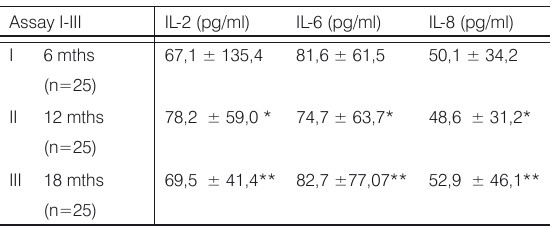
Table 2. Serum IL-2, IL-6 and IL-8 concentrations in renal transplantation